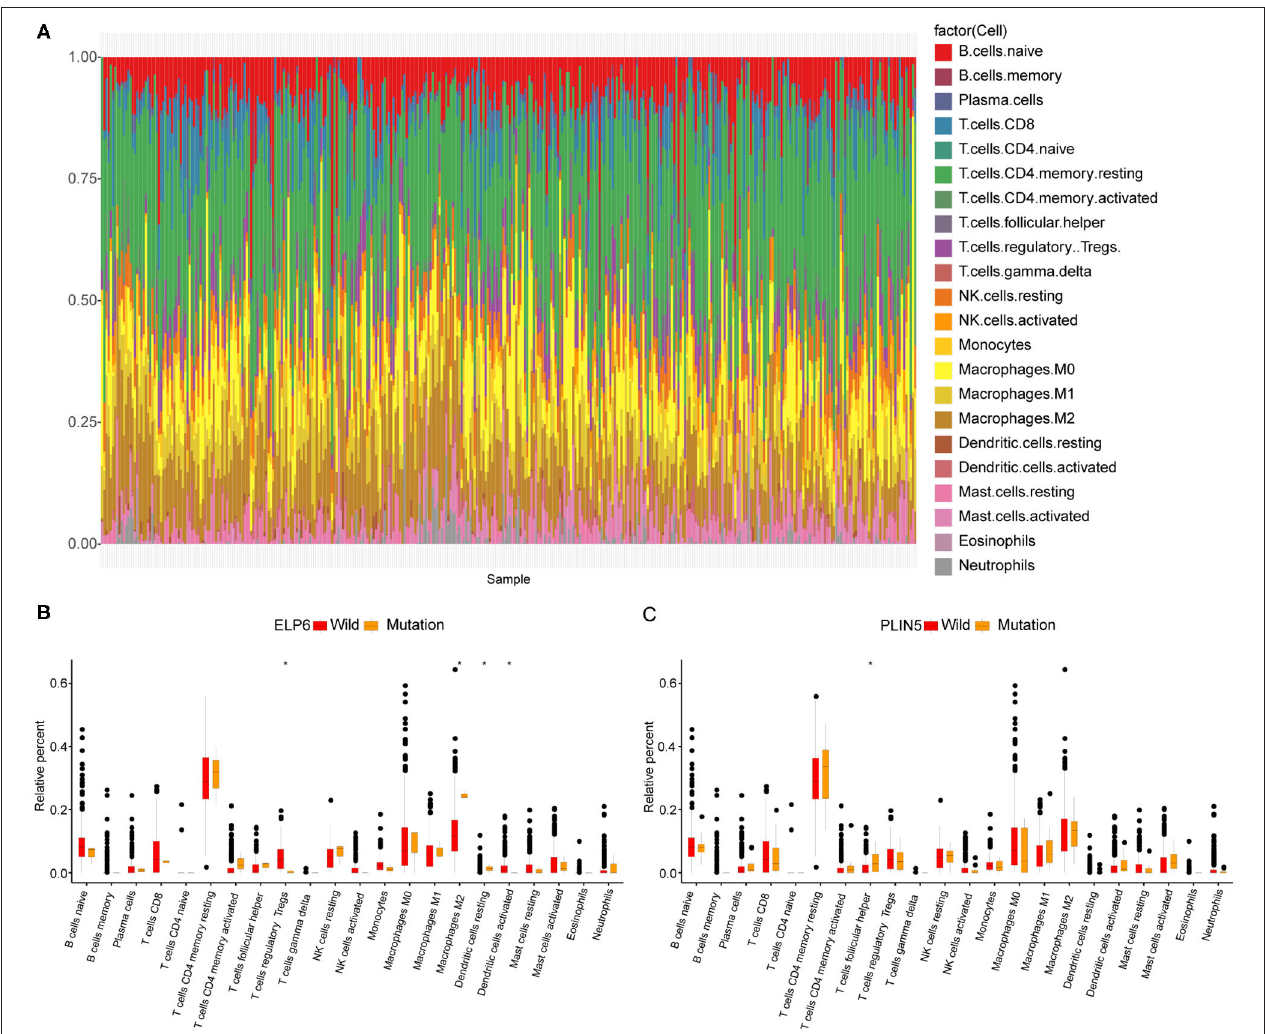
FIGURE 2 | Immune cell infiltration in wild-type and mutant patients with gastric cancer (GC). (A) The infiltration proportions of 22 types of immune cells in all patients with GC. (B) Tumor infiltrating immune cell difference between wild-type and mutated ELP6 GC samples. (C) Tumor infiltrating immune cell difference between wild-type and mutated PLIN5 GC samples. * p -value <